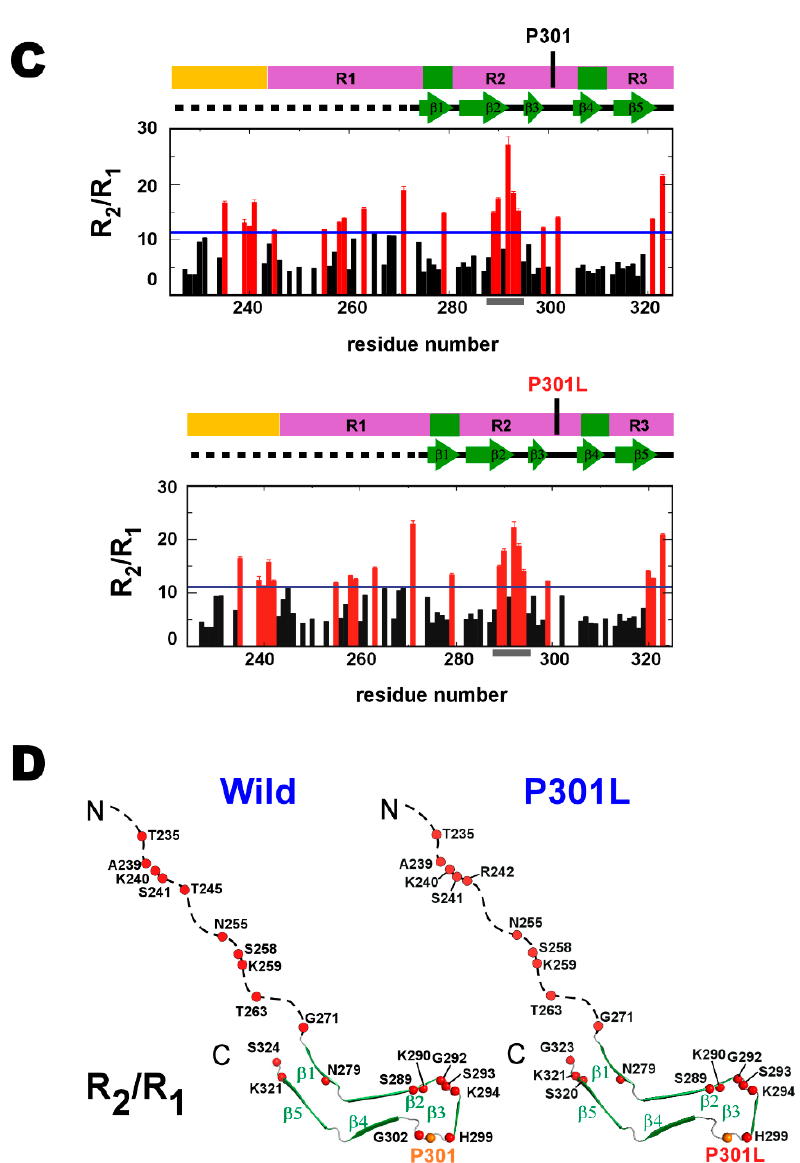
Figure 2. Comparing the conformational dynamic parameters between the wild-type and P301L mutant TauF4 Δ . ( A ) Heteronuclear 1 H- 15 N nuclear Overhauser effects (hNOEs) are plotted. The upper and lower panels are the wild-type and P301L mutant TauF4 Δ .The domain architecture of tau and the secondary structures formed in the heparin-induced tau filament are drawn on each plot. hNOE values that are larger than the average value (blue line) are marked in red. The gray bars indicate the positions for β 3 and β 5. ( B ) Residues with hNOE values greater than the average are marked by red circles on the heparin-induced tau filament structure (PDB ID: 6QJH) [19]. ( C ) R 2 / R 1 values; the wild-type (upper) and the P301L mutant (lower). R 2 / R 1 values shown in red are higher than the average value (blue line). Gray bars mark the position for the linker connecting β 2 and β 3. ( D ) Residues with R 2 / R 1 values above the average are marked by red circles on the tau filament structure.